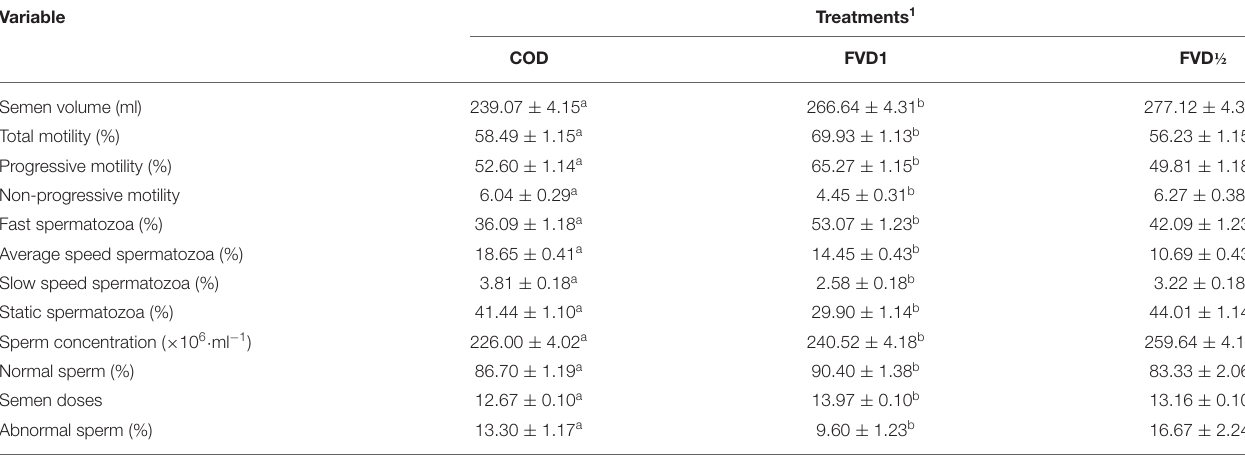
TABLE 3 | Effect of dietary fat-soluble vitamin supplementation on seminal characteristics (mean ± SEM) in boar ejaculates during the breeding season. Variable